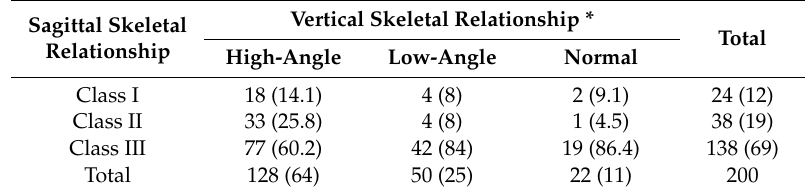
Table 1. Distribution of vertical and sagittal skeletal relationships among study patients, N (%).